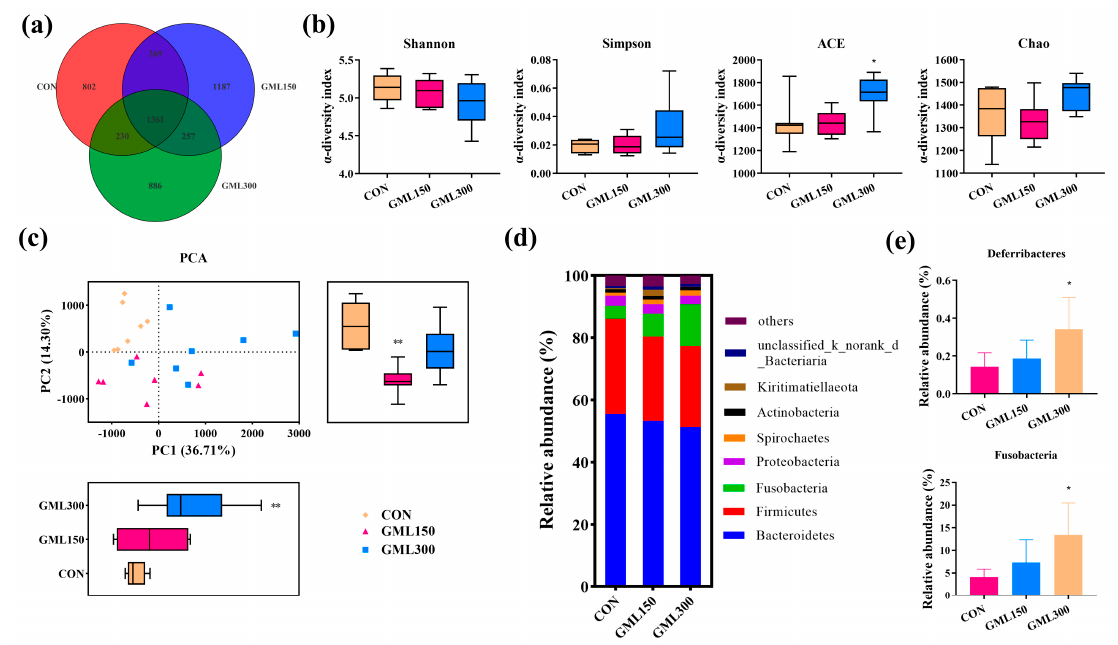
Figure 3. GML supplementation altered the gut microbiota community in hens. ( a ) A Venn diagram showing operational taxonomic units (OTUs) di ff erences among treatments. ( b ) α -diversity: Chao, ACE, Shannon and Simpson. ( c ) β -diversity: principal component analysis (PCA). ( d ) Phylum level among di ff erent groups. ( e ) Di ff erential phyla detected among di ff erent groups. Data are expressed as means ± SD ( n = 7). Asterisk indicates significantly di ff erences according to the Kruskal–Wallis test (* p < 0.05, ** p < 0.01).